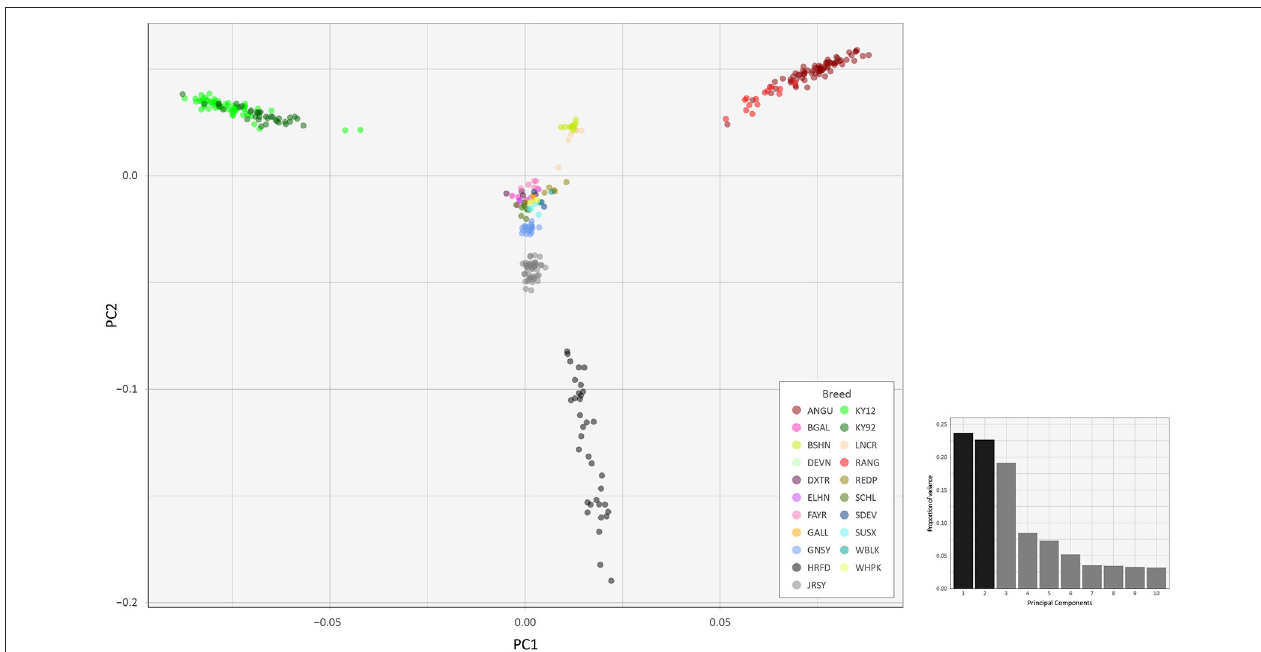
FIGURE 5 | Principal component analysis plot constructed for PC1 and PC2 from genome-wide SNP data (37,395 autosomal SNPs) for the BI data set of 351 individual animals. The smaller histogram plot shows the relative variance contributions for the first 10 PCs and PC1 and PC2 account for 23.7% and 22.7% of the total variation for PC1–10,